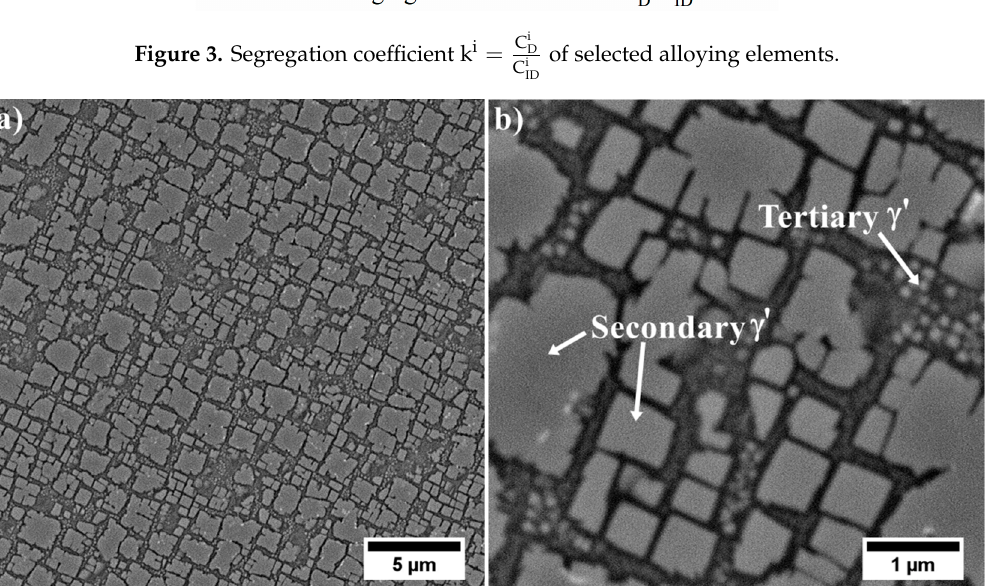
Figure 3. Segregation coe ffi cient k i = C